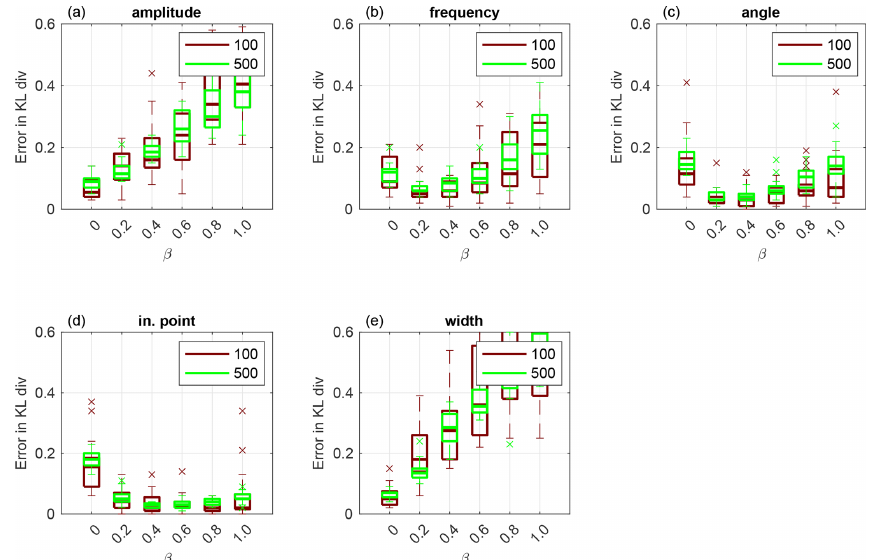
Figure 4. Application to F2 parameterisation using Sinkhorn approximation. Box plot over 20 independent simulations of KL divergence for geometrical parameters: amplitude (a) , frequency (b) , angle (c) , initial point (d) and width (e) . The horizontal axis is for the hybrid parameter, where β = 0 corresponds to the EKI and β = 1 to TET(S)PF. Ensemble size M = 100 is shown in red and M = 500 in green. The central mark is the median, the edges of the box are the 25th and 75th percentiles, whiskers extend to the most extreme data points and crosses are outliers.